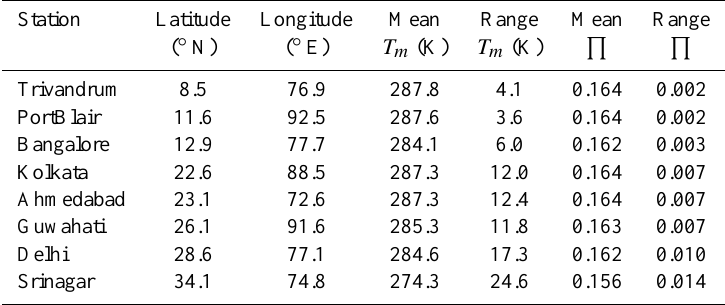
Table 1. Mean value of T m and 5 along with their range of variability at different Indian stations. Station Latitude Longitude Mean Range Mean Range ( ◦ N) ( ◦ E) T m (K) T m (K) Q Q Trivandrum 8.5 76.9 287.8 4.1 0.164 PortBlair 11.6